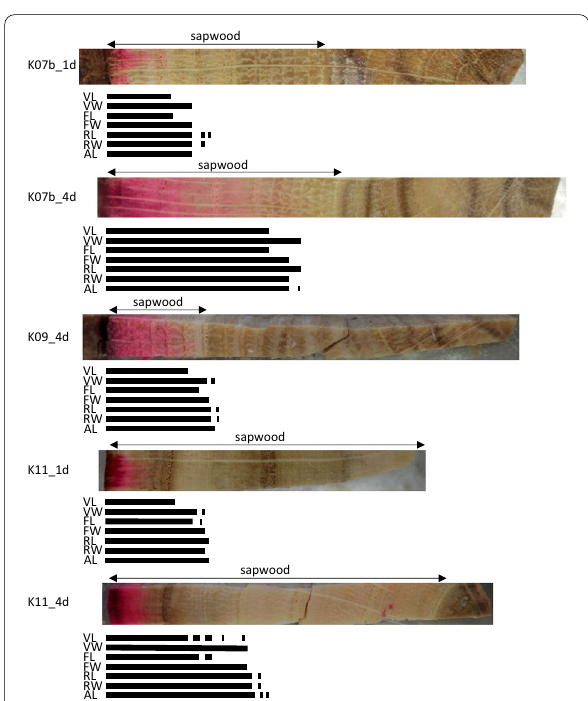
Fig. 4 Schematic representation of the radial distribution of cesium (Cs) in the xylem of freeze–thaw treated konara oak ( Quercus serrata ) trees after 1- or 4-day injection as observed using cryo-scanning electron microscopy/energy-dispersive X-ray spectroscopy (cryo-SEM/EDX). For abbreviations, please refer to Fig.